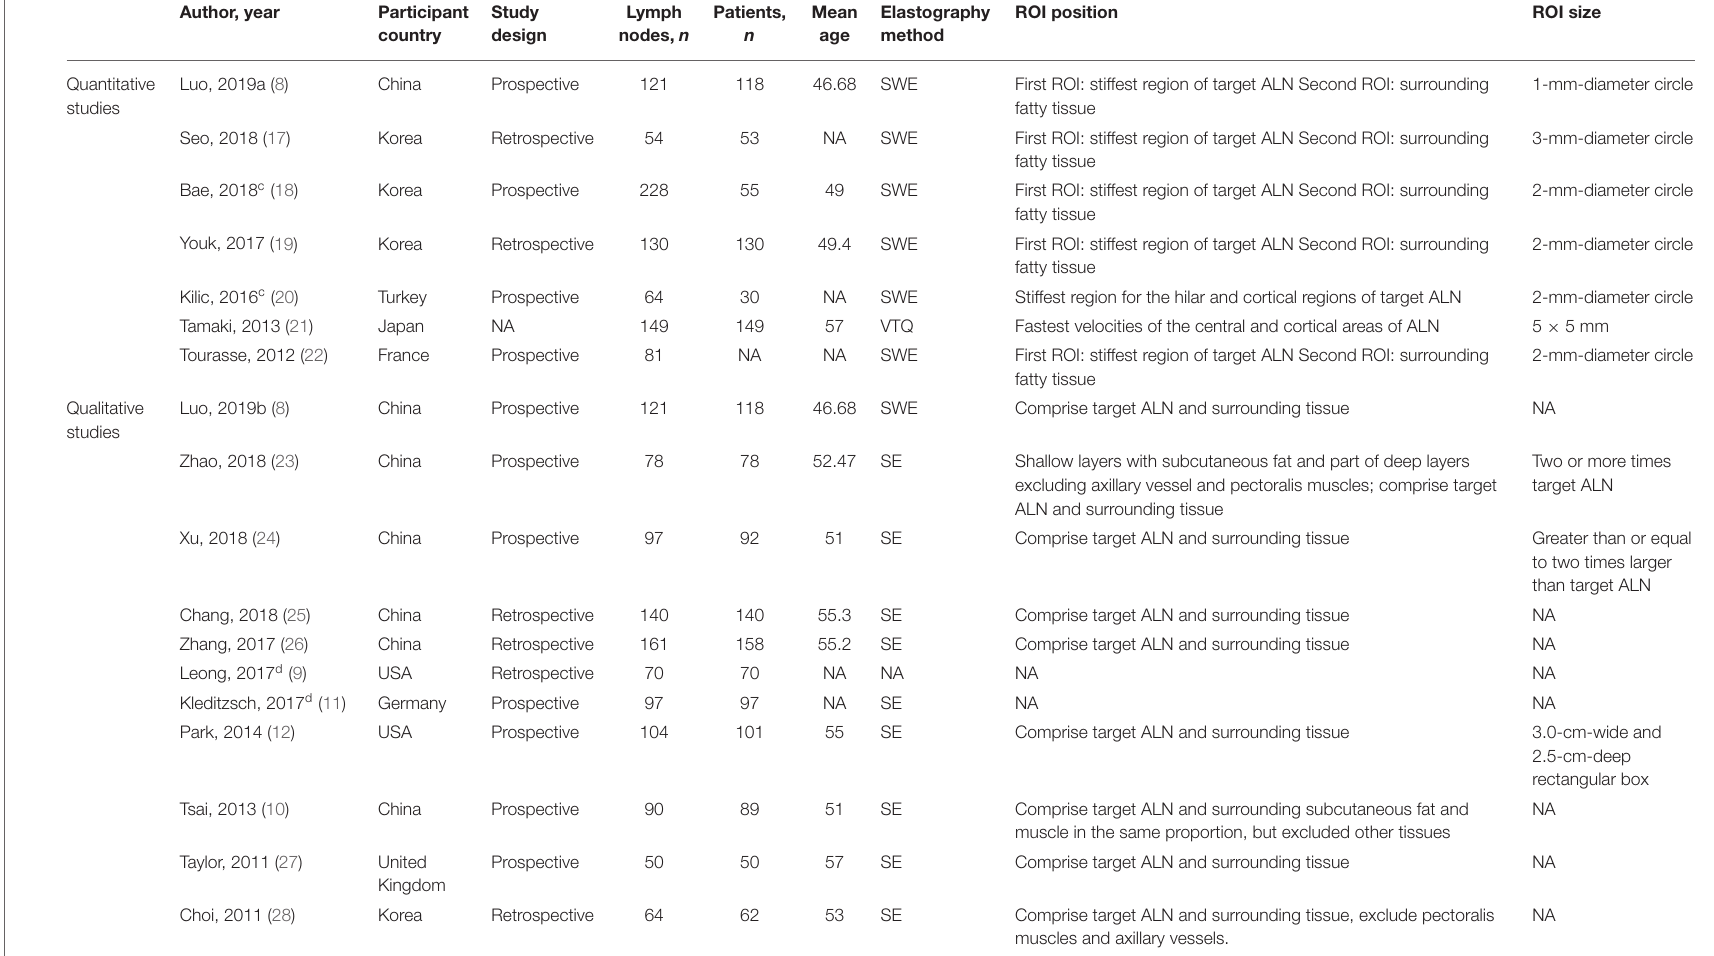
TABLE 1 | Characteristics of the included studies.